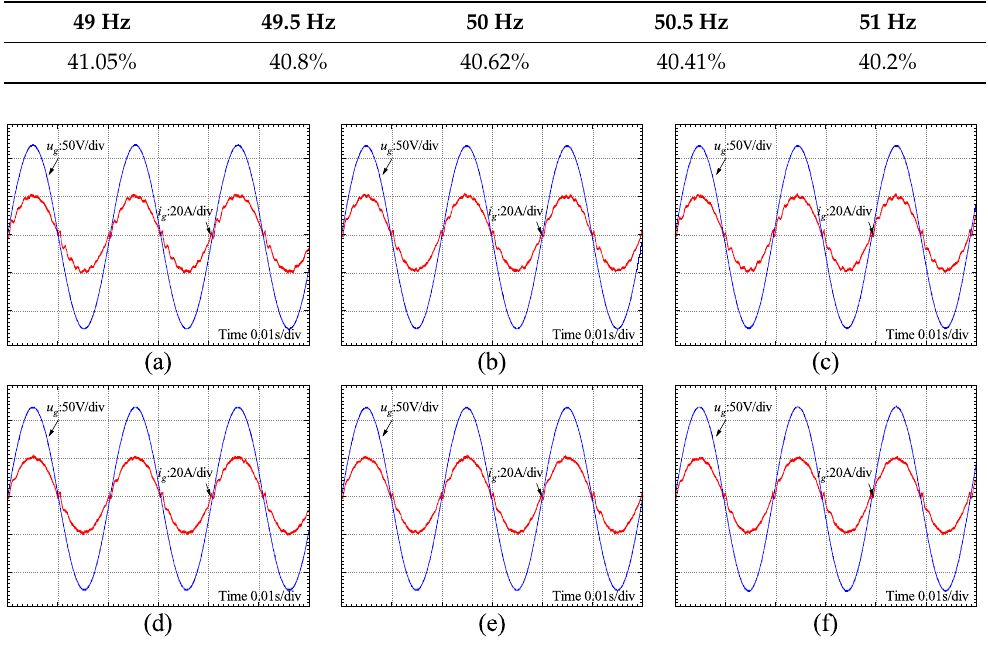
Figure 18. The waveform of grid voltage u g and grid current i g when L 1 e = 0.1 mH, L 2 = 3.5 mH, and C f = 7.5 µ F. ( a – c ): using FIR filters when the grid frequency is 49 Hz, 50 Hz, and 51 Hz. ( d – f ): using IIR filters when the grid frequency is 49 Hz, 50 Hz, and 51